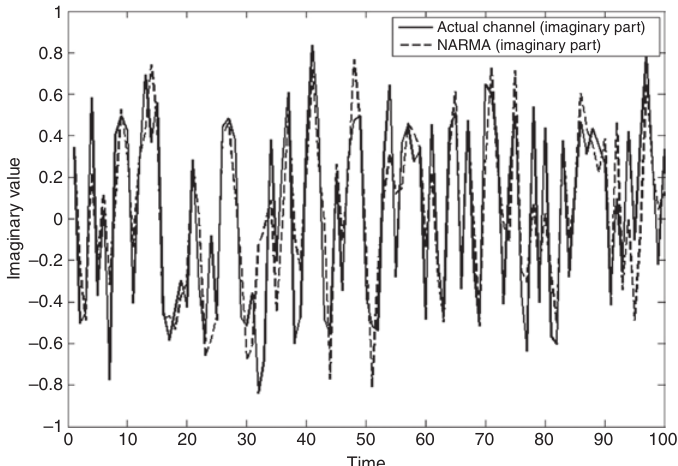
Figure 8: Channel Gain Plot (Imaginary) for Case